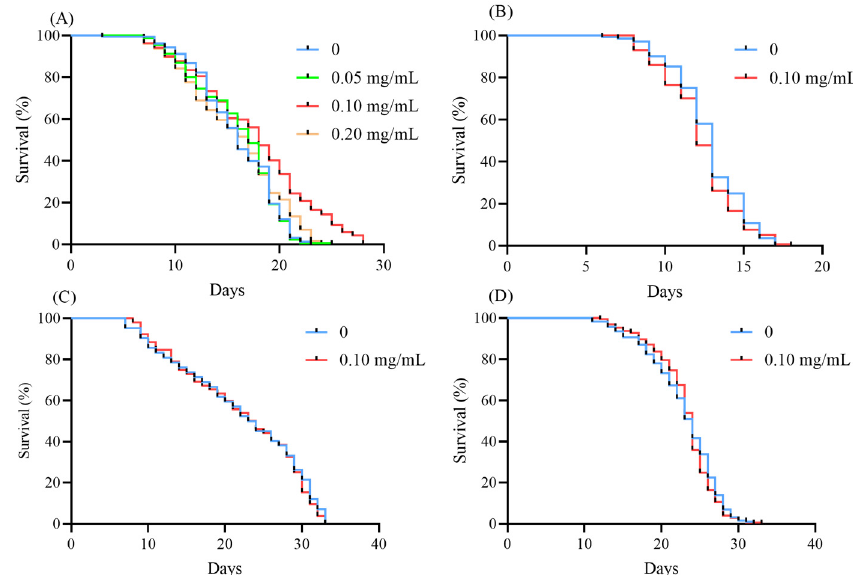
Figure 5. The effect of EBL on the lifespans of ( A ) wild-type worms. Additionally, EBL showed an extended effect on N2 worms. The effect of EBL on the mutants involving the insulin signaling pathway, such as ( B ) TJ1052 age-1 ( hx546 ), ( C ) CF1038 daf-16 ( mu86 ), and ( D ) CB1370 daf-2 ( e1370 ) strains. Table 1. The mean lifespans of four types of worms in the presence of EBL. Stains Treatment Numbers of Trials Significance Mean Lifespan (Days)